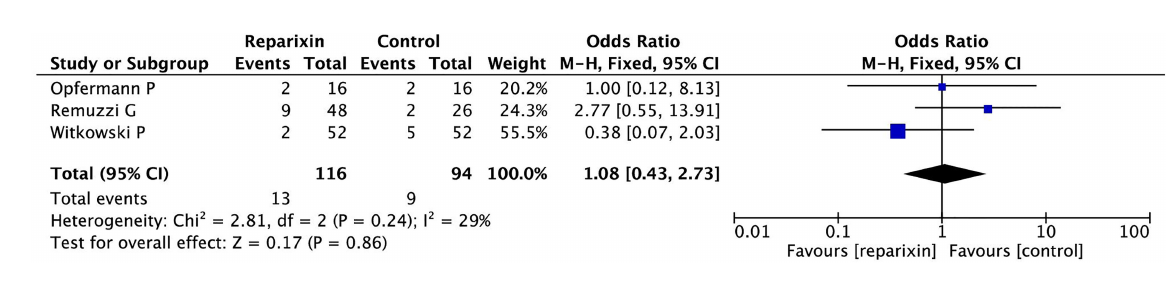
FIGURE 5 Forest plot of the effect of reparixin on the occurrence of a non-serious